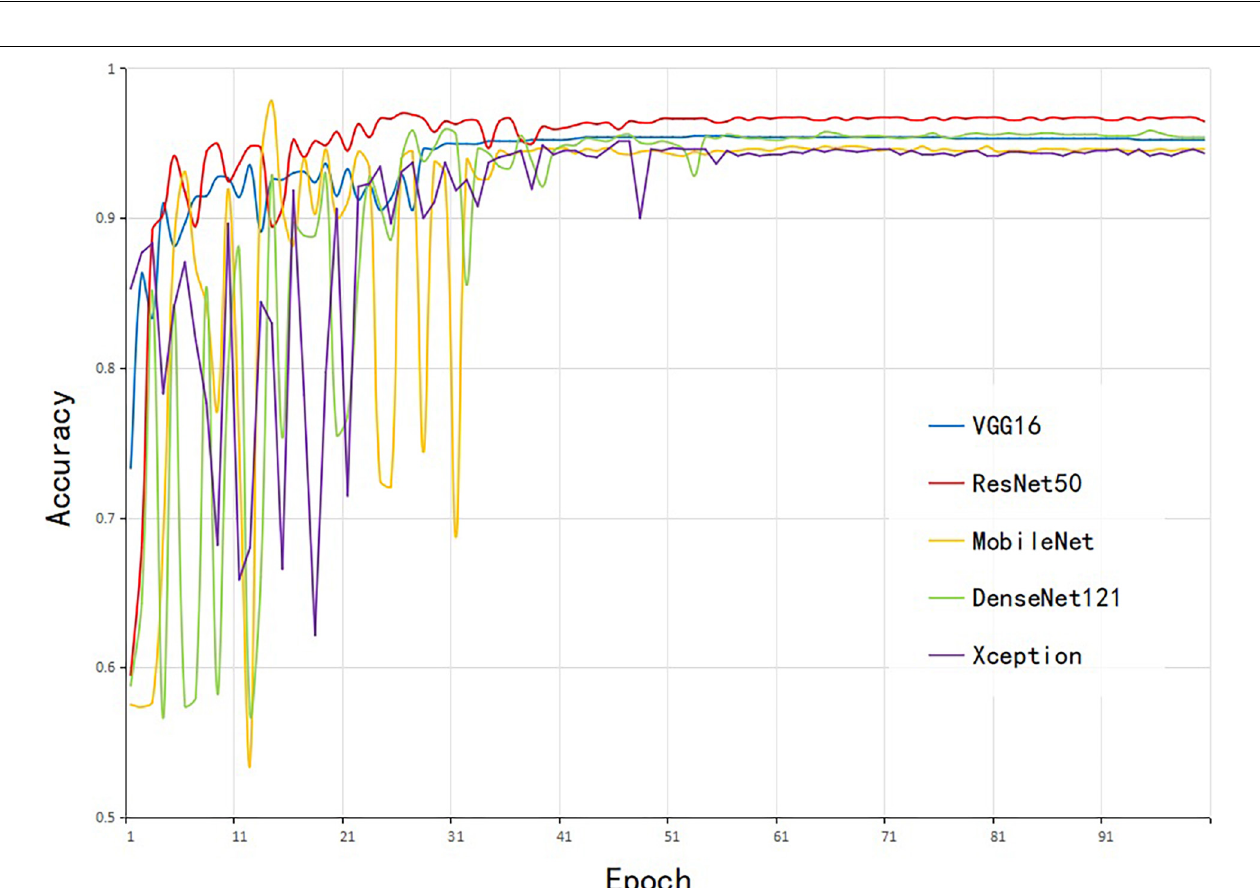
FIGURE 6 | The accuracy of the five models for the test